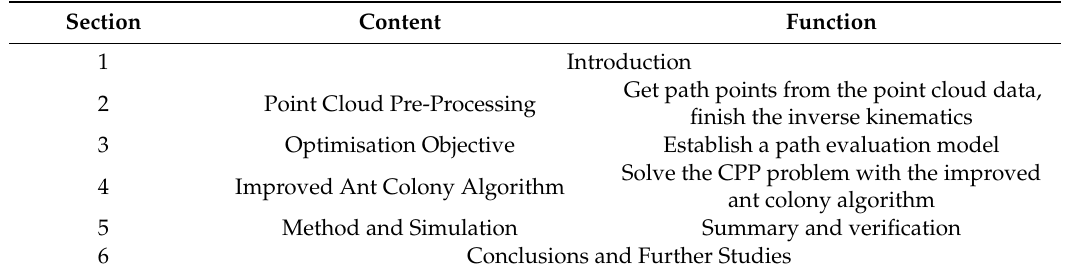
Table 1. Contents and functions of each